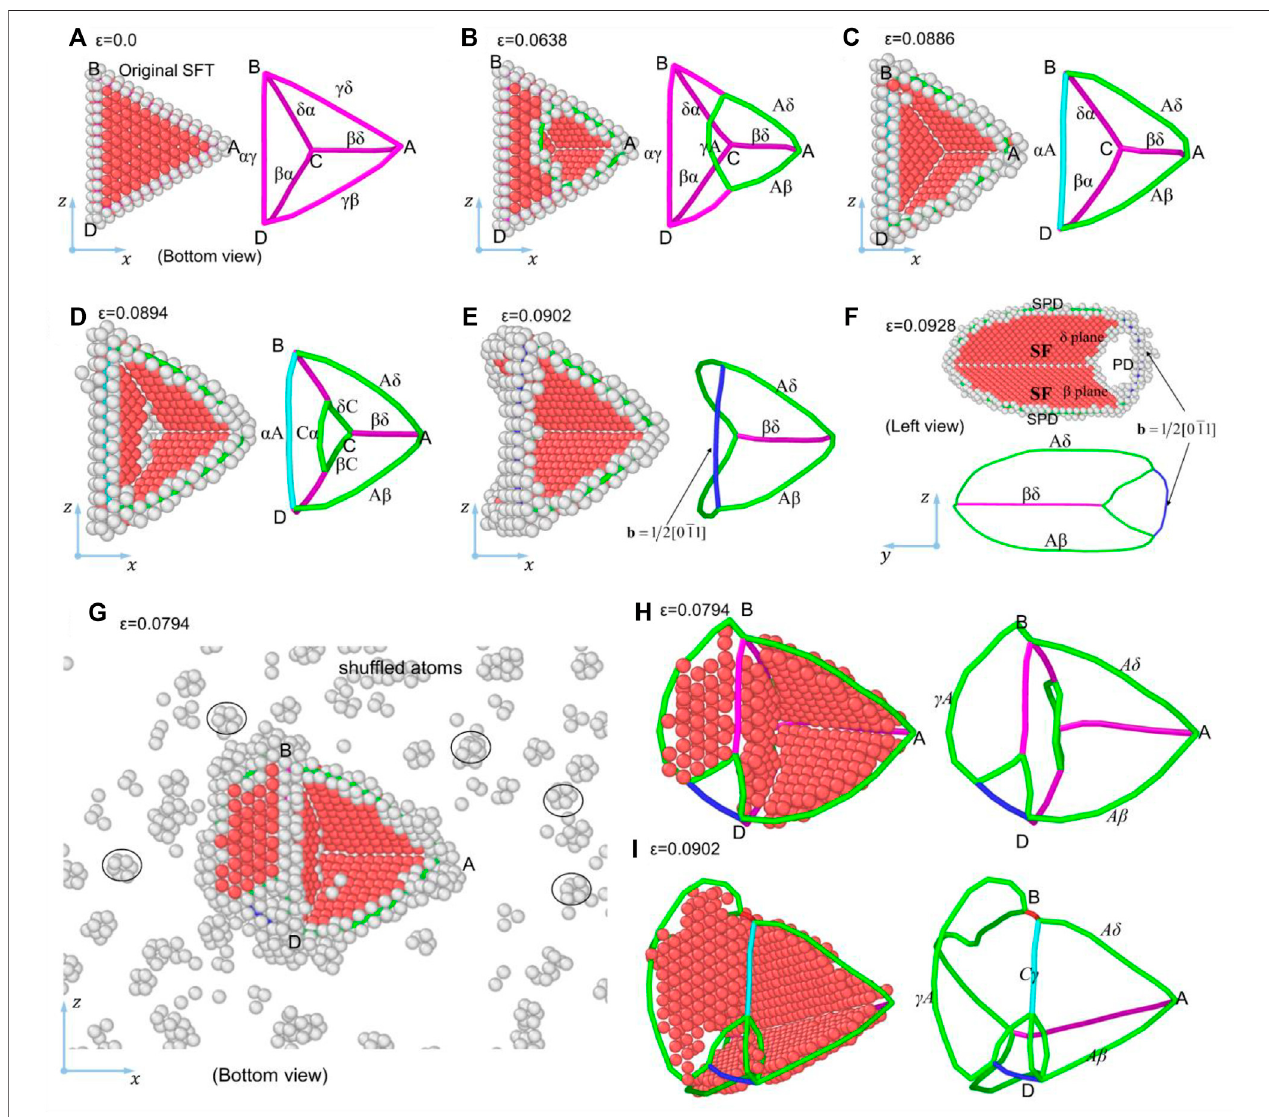
FIGURE 3 | Atomic structure of SFTs in Ni and CoCrFeNiMn samples sheared along ( 111 )[ 112 ] at different strains. (A – F) Ni; (G – I) CoCrFeNiMn HEA.